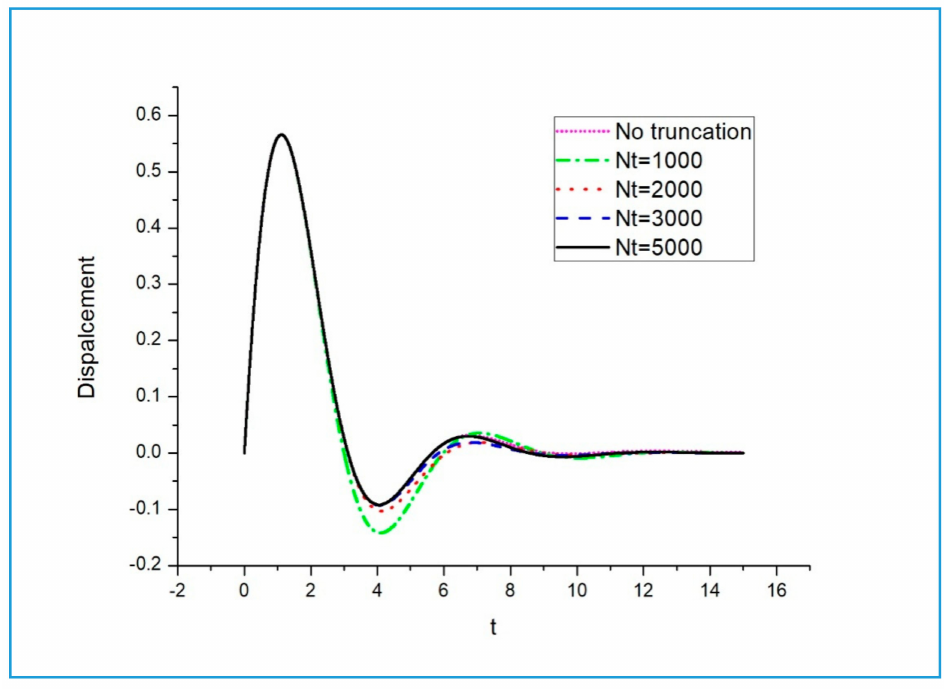
Figure 1. Numerical solutions of original definition method (No truncation) and short memory principle